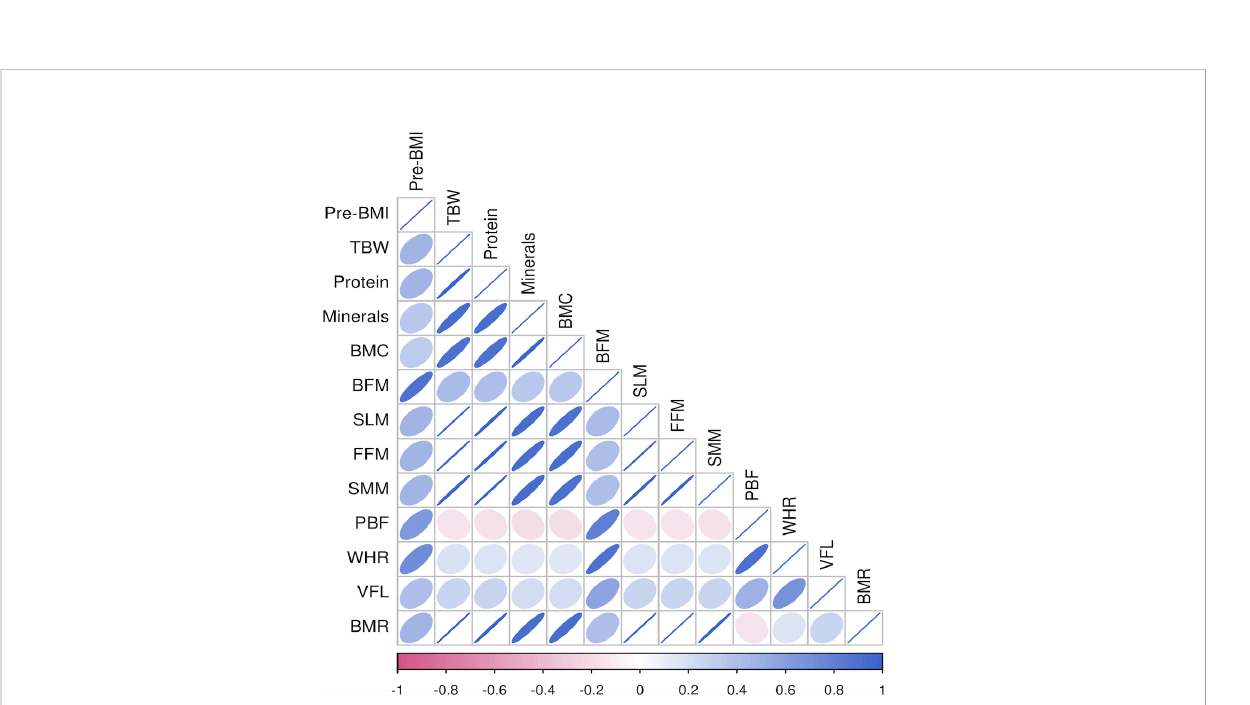
FIGURE 4 Heat map of body composition correlation in pregnant women with former BMI ≥ 24kg/m 2